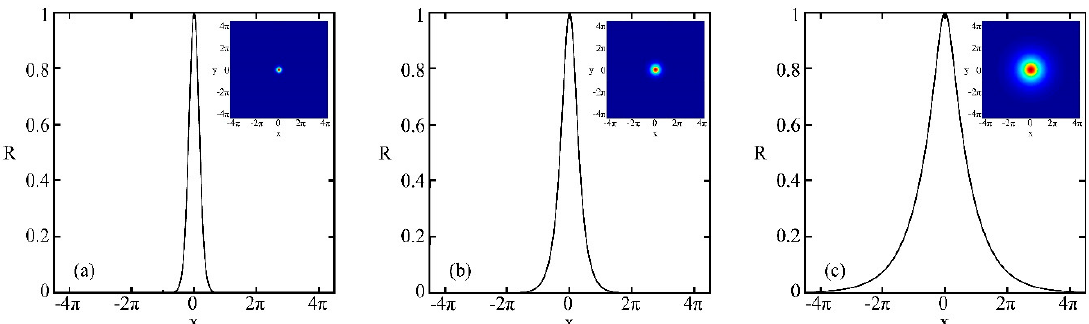
Figure 1. The response of nonlinearity, R , when ( a ) the degree of nonlocality ( d ) = 0.05, ( b ) d = 0.5, and ( c ) d = 5. In these figures, x refers to the horizontal coordinates. The insets of each picture are the corresponding transverse profiles of R . The amplitude of each R is normalized.